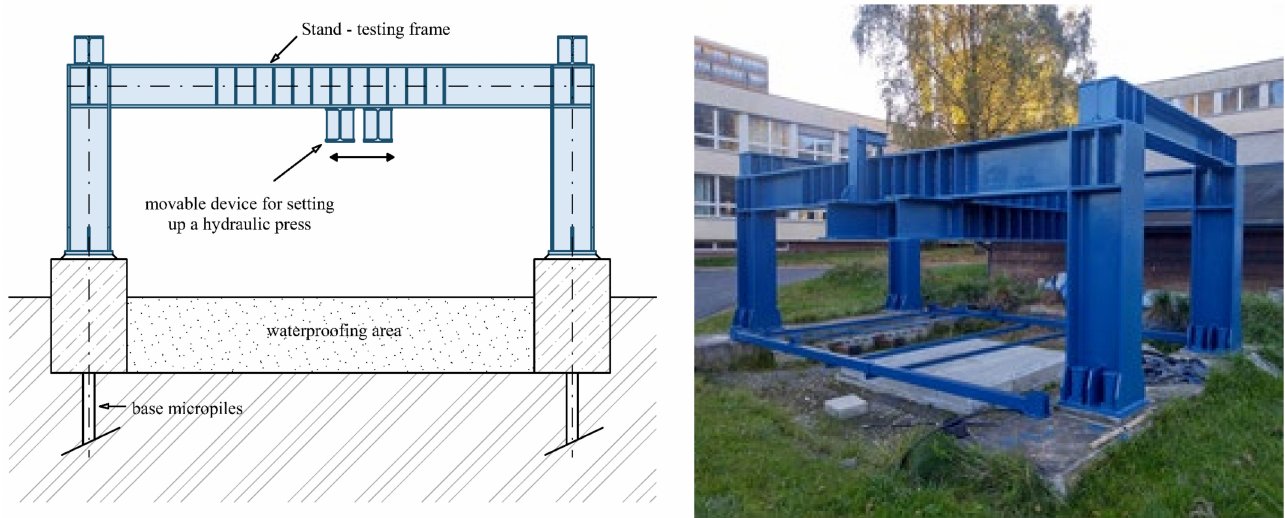
Figure 4. Specialized loading equipment